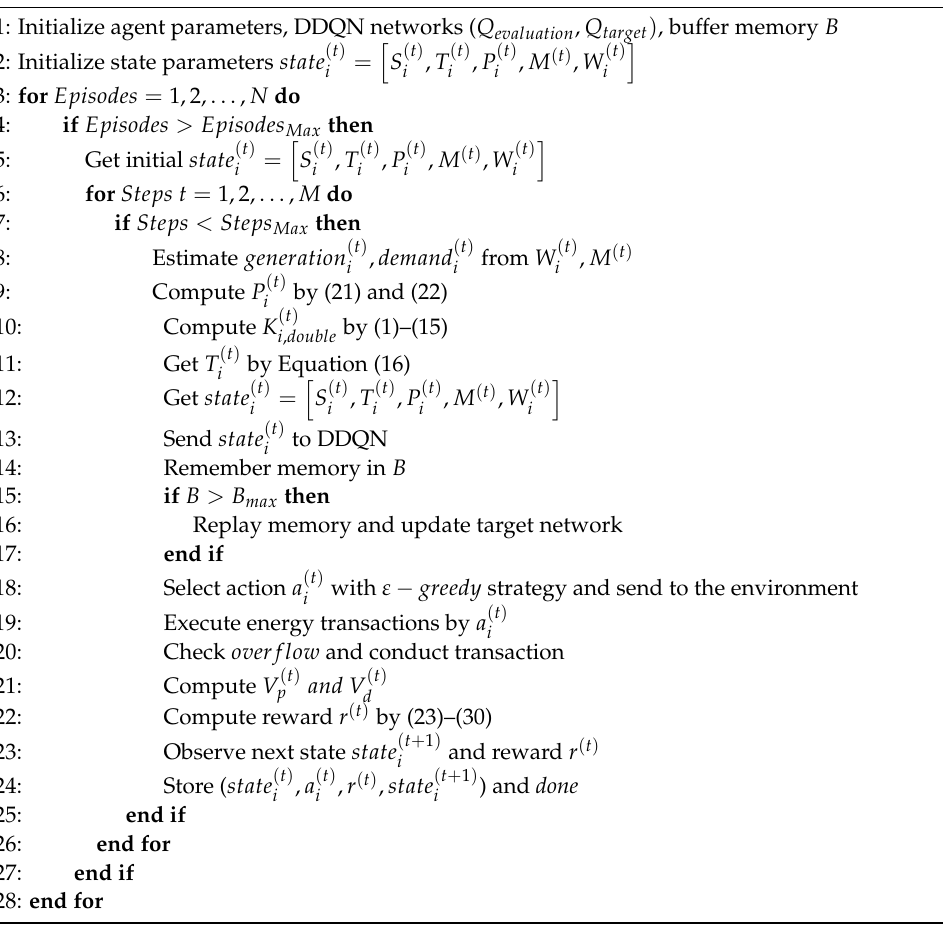
Algorithm 1 Proposed DDQN algorithm-based energy trading